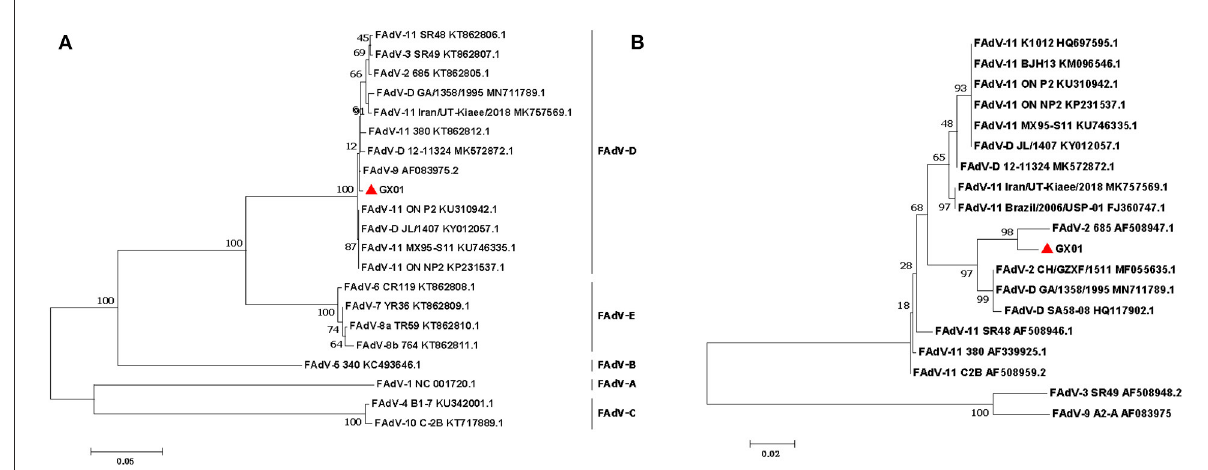
FIGURE4 Phylogenetic analysis of strain GX01. The phylogenetic trees were constructed by the maximum likelihood method in MEGA 7.0. Bootstrap majority consensus values based on 1,000 replicates are indicated at each branch point as a percentage. (A) Phylogenetic tree based on amino